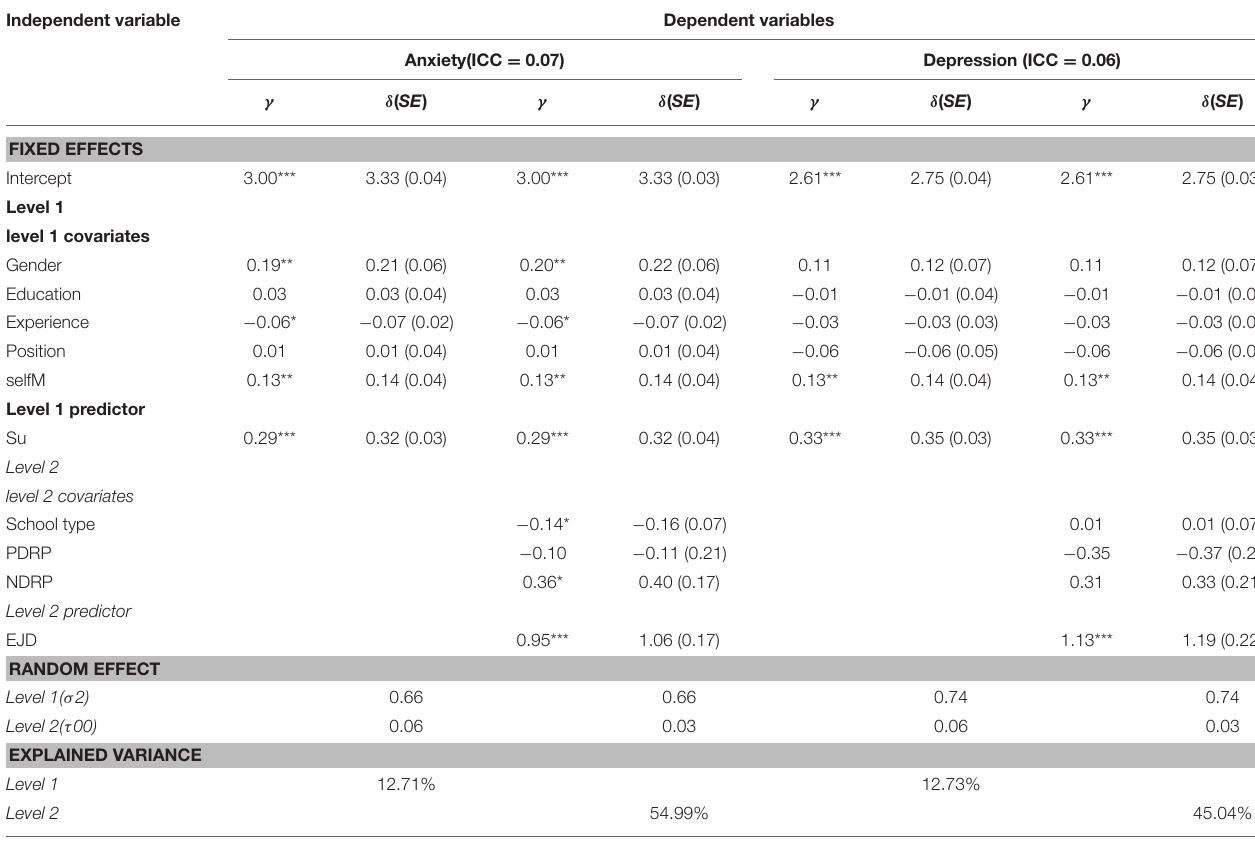
TABLE 2 | Multilevel estimates for models predicting anxiety and